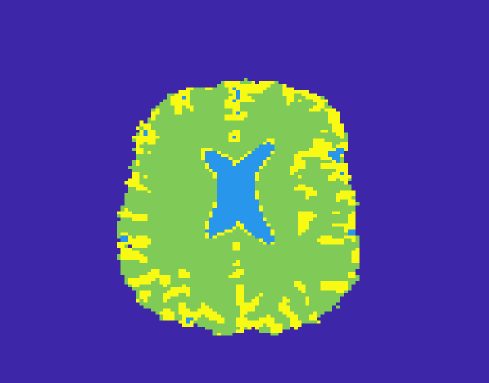
Figure 8. Classification of brain into white matter (green), grey matter (yellow), and cerebrospinal fluid